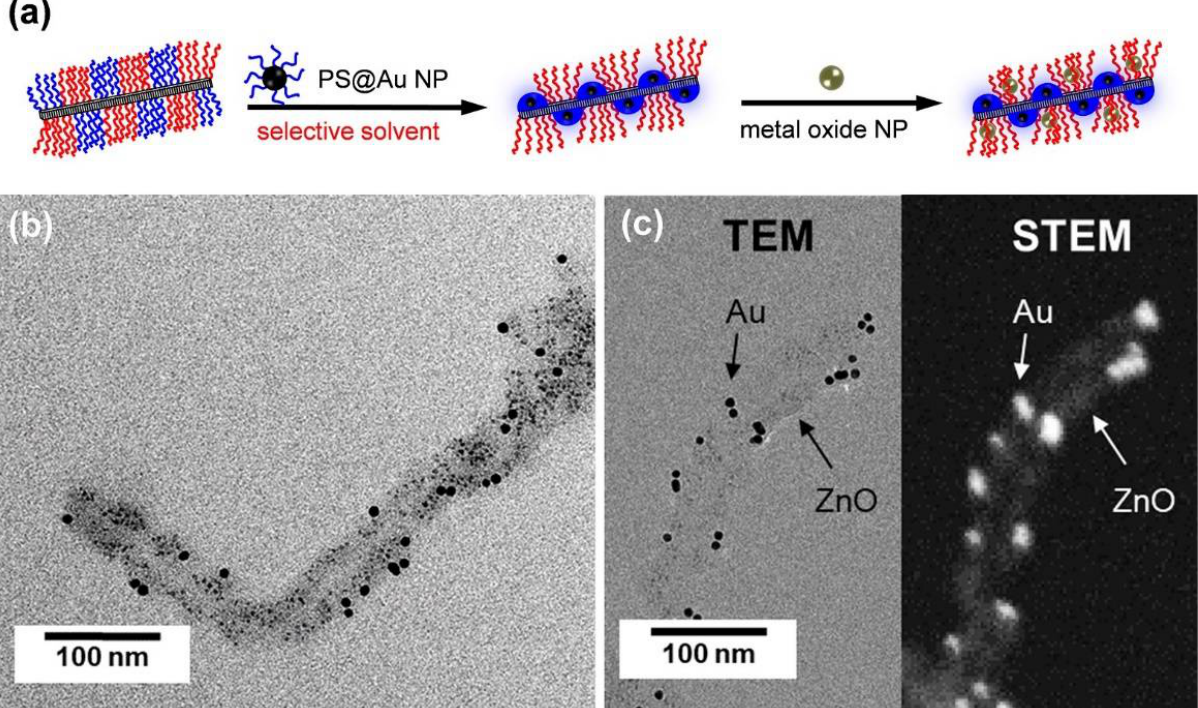
Figure 10. ( a ) Schematic depiction of the regio-selective, binary loading of patchy SEDMA wCCMs with PS-stabilized gold (Au) NPs and zinc oxide (ZnO) NPs, respectively (PS is displayed in blue, PE in black, and PDMA in red). ( b ) TEM image of S 415 E 830 DMA 420 wCCMs binary-loaded with Au and ZnO NPs. ( c ) Bright-field (left) and high-angle annular dark-field scanning transmission electron microscopy (HAADF-STEM, right) images, clearly revealing the binary loading with two different NP types. Reproduced and adapted from [138] with permission of RSC.